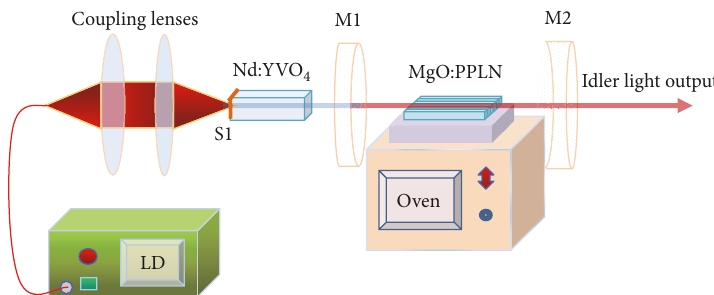
Figure 1: Schematic diagram of LD end-pumped intracavity singly resonant optical parametric oscillator